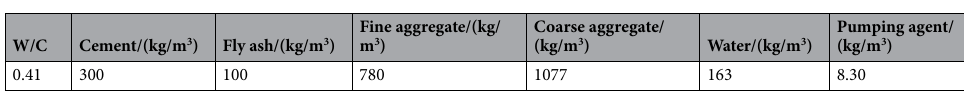
Table 1. Mixture proportion of